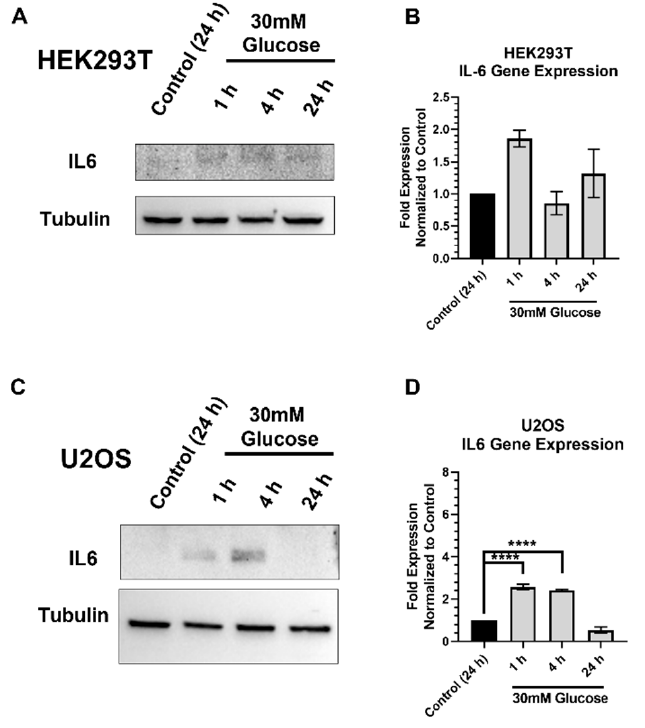
Figure 9. Acute high glucose stimulates IL-6 protein and gene expression: ( A ) Representative immunoblots showing increased IL-6 following acute high glucose 30mM for 1, 4, and 24h in HEK293T. ( B ) IL-6 gene expression in HEK293T normalized to control. ( C ) Representative immunoblot showing increased IL-6 following acute high glucose 30mM for 1, 4, and 24 h in U2OS. ( D ) IL-6 gene expression in U2OS normalized to control. **** p < 0.0001.